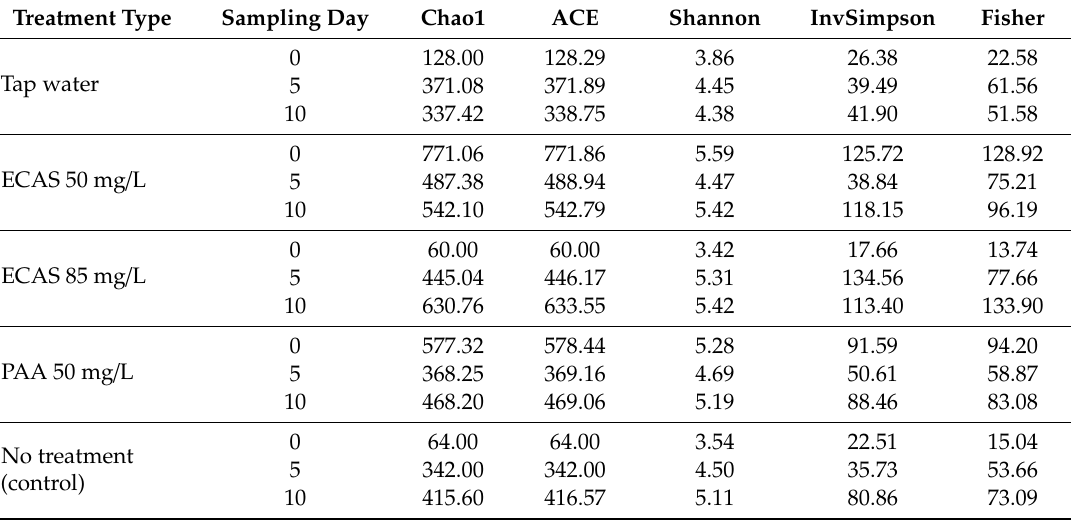
Table 2. Alpha diversity metrics of species richness (Shannon and Inverse Simpson & Fisher) and evenness (Chao1 and abundance-based coverage estimator, ACE) for all